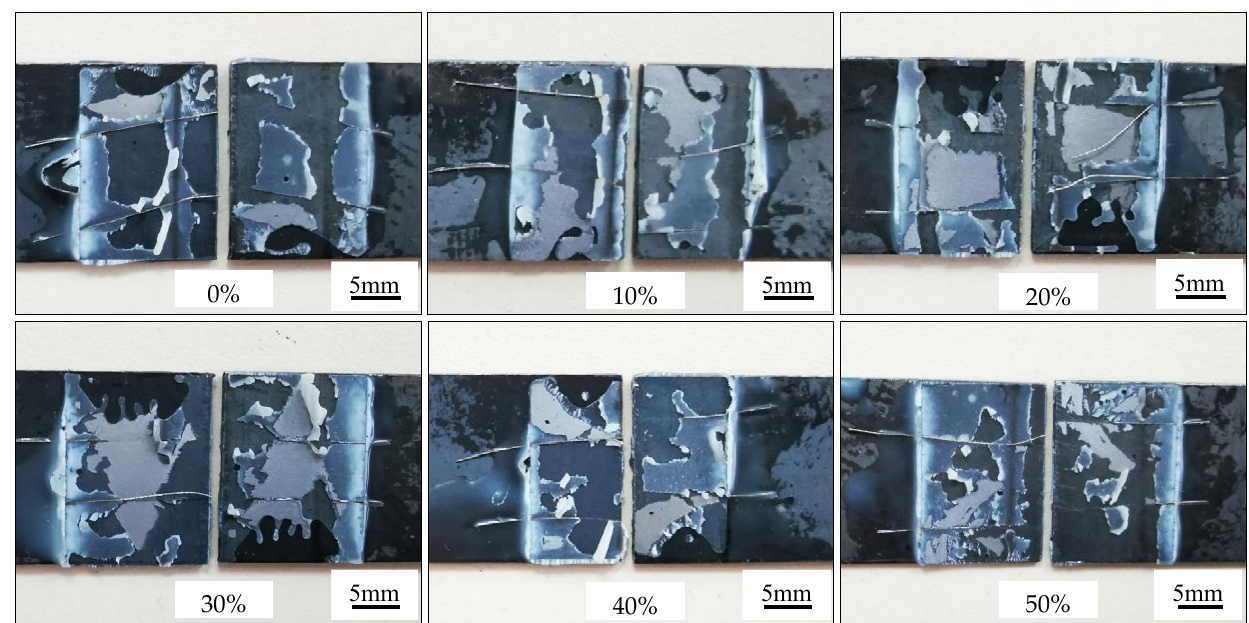
Figure 17. Lap shear strength testing of AS60/60 coating at different reduction ratios at TAUS = 930 ◦ C for 5